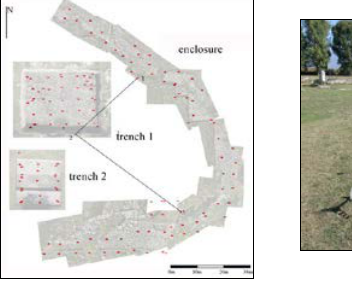
Figure 17. Distribution of control and check points.